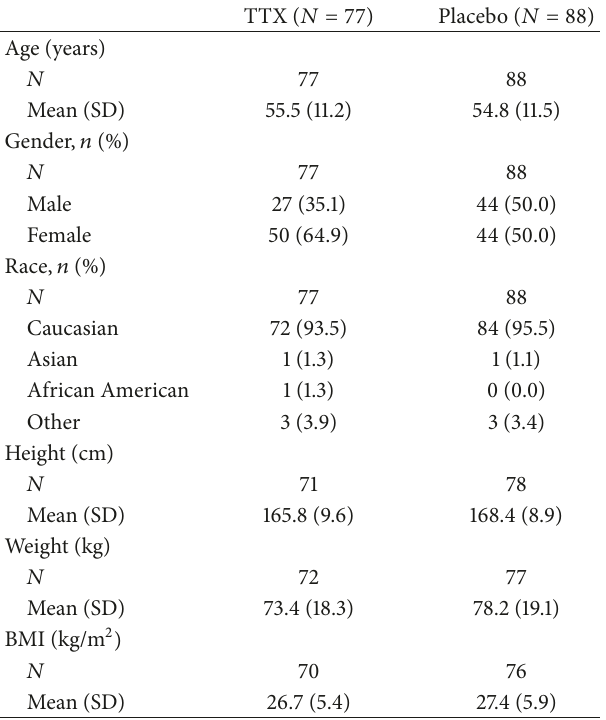
Table 1: Patient